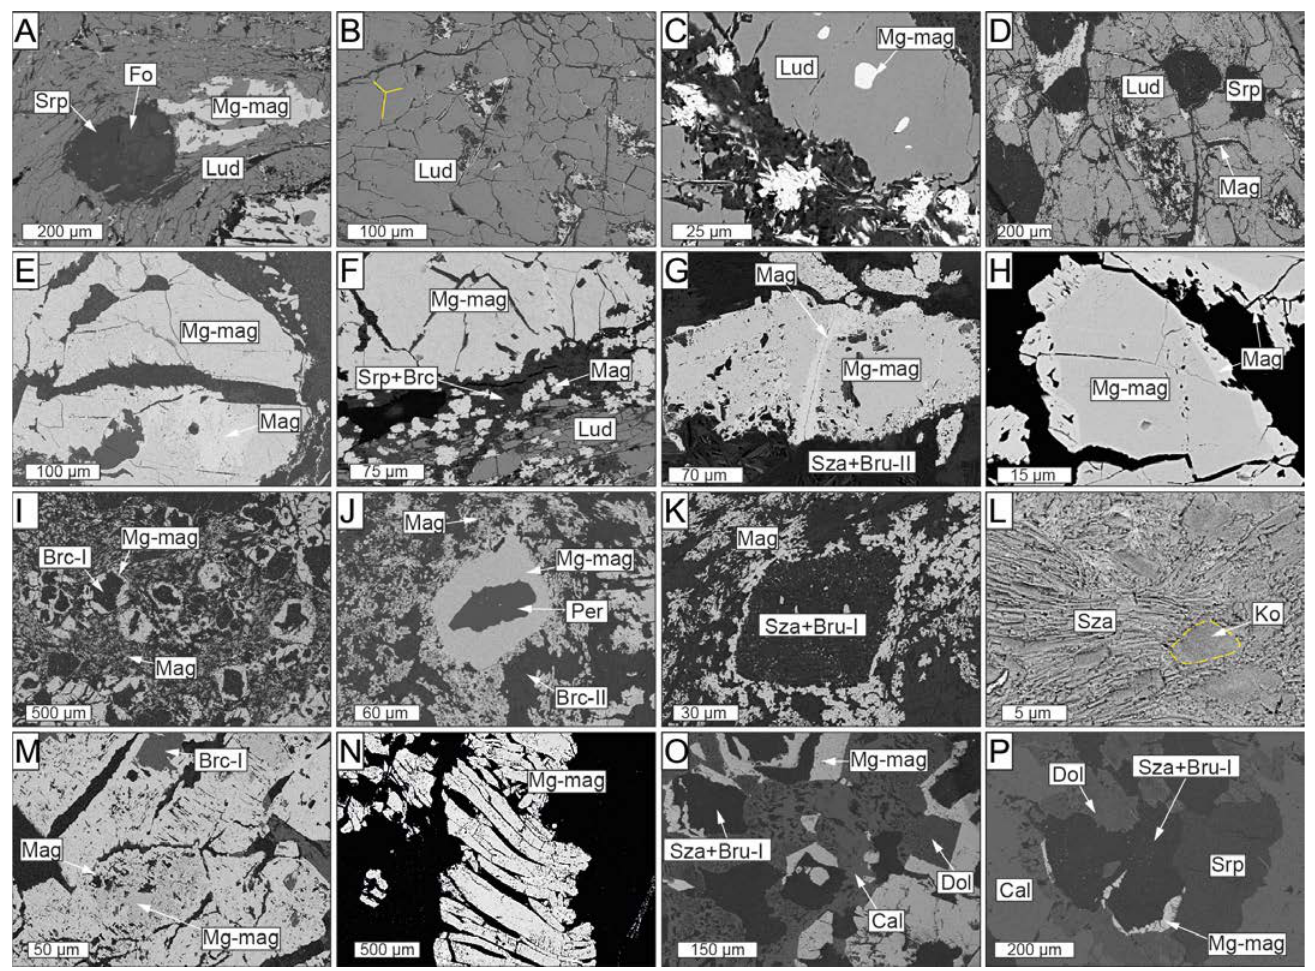
Figure 5. Scanned electron microscopy images showing the different textures of the El Robledal deposit ore minerals. The pictures are arranged from the top to the bottom of the deposit. Ludwigite–magnetite zone: ( A ) Deformed ludwigite from the upper part of the mineralized body including partially serpentinized forsterite and anhedral Mg-rich magnetite interstitial to ludwigite. ( B ) Granoblastic, massive ludwigite with a 120° triple junction (marked with yellow lines). ( C ) Euhedral Mg-rich magnetite inclusion in ludwigite. ( D ) A partially dissolved core of ludwigite infilled by an intergrowth of Mg-rich magnetite and fine-grained, fibrous, or flake-like hydrotalcite group minerals. ( E ) Mg-rich magnetite grain partially altered to magnetite along fractures. ( F ) Mg-rich magnetite replaced by magnetite along boundaries and fractures. Portions of magnetite are dismembered within the fracture filled with cataclasized ludwigite. ( G ) Partially altered Mg-rich magnetite grain embedded in a szaibelyite and brucite-II matrix. ( H ) Porous textures of magnetite replacing Mg-rich magnetite. ( I ) Euhedral Mg-rich magnetite with brucitized cores after periclase. ( J ) Non-fractured Mg-rich magnetite grains with unaltered periclase core. ( K ) Dismembered magnetite defining the borders of a pseudomorph, now replaced by szaibelyite and brucite-I, including rounded, tiny magnetite particles. ( L ) Kotoite relicts partially replaced by tabular szaibelyite. Magnetite–szaibelyite zone: ( M ) Magnetite replacing Mg-rich magnetite along fractures and boundaries including brucitized cores. Note that the grade of replacing is higher than in the ludwigite–magnetite zone. ( N ) Elongated and deformed Mg-rich magnetite grains with pull-apart fractures. ( O ) Edges of Mg-rich magnetite with brucitized cores after periclase included in a dolomite and calcite matrix. ( P ) Dolomite rims around Mg-rich magnetite replaced by szaibelyite and brucite-I, including rounded, tiny magnetite particles. The Mg-rich magnetite exhibits different textures within the ludwigite–magnetite zone: (1) Mg-rich cores partially replaced by magnetite along fractures and